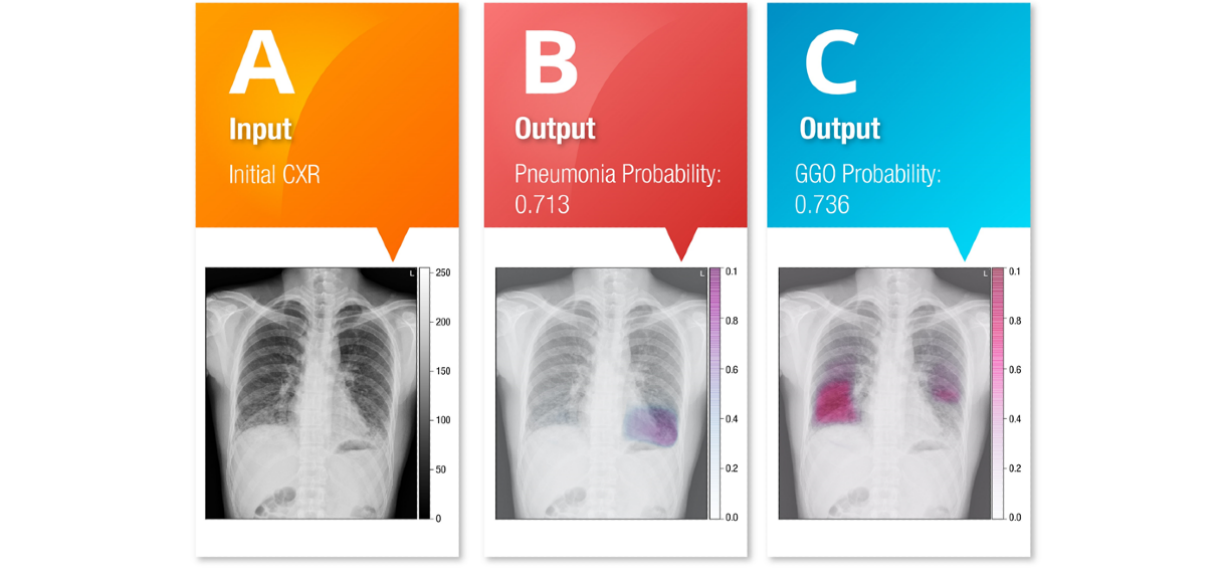
Figure 6. The artificial intelligence (AI) model for pneumonia detection incorporated into the smart clinical assisting system. (A) An original chest x-ray is automatically retrieved from the picture archiving and communication system and then interpreted by the AI model. (B) A consolidative lung is detected, and the diseased site is illustrated using a heat map. (C) A light consolidation GGO is identified by the AI model. CXR: chest x-ray; GGO: ground-glass opacity.